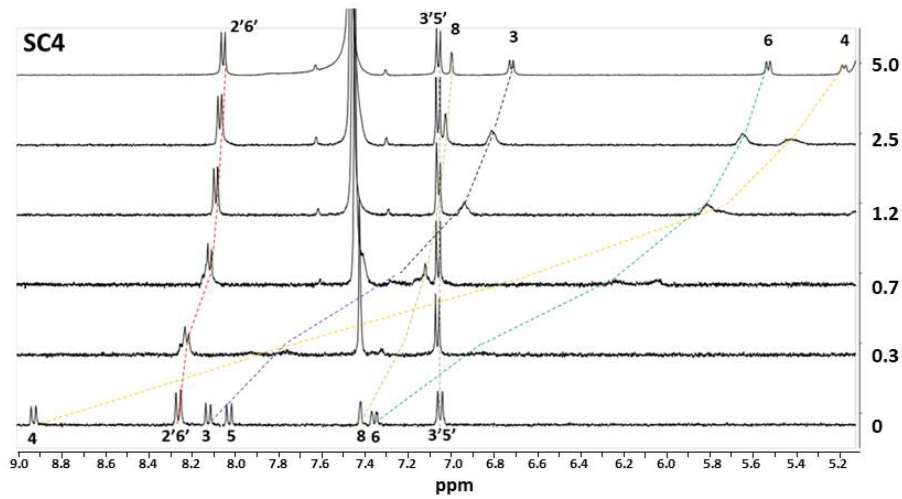
Figure 4. 1 H NMR spectra variations of 4 (cid:48) 7-DHF (6 × 10 − 4 M) solution upon titration with increasing Figure 4 . 1 H NMR spectra variations of 4′7-DHF (6 × 10 −4 M) solution upon titration with increasing concentrations of the host: 0, 0.3, 0.7, 1.2, 2.5, and 5 equivalents of SC4. concentrations of the host: 0, 0.3, 0.7, 1.2, 2.5, and 5 equivalents of SC4.